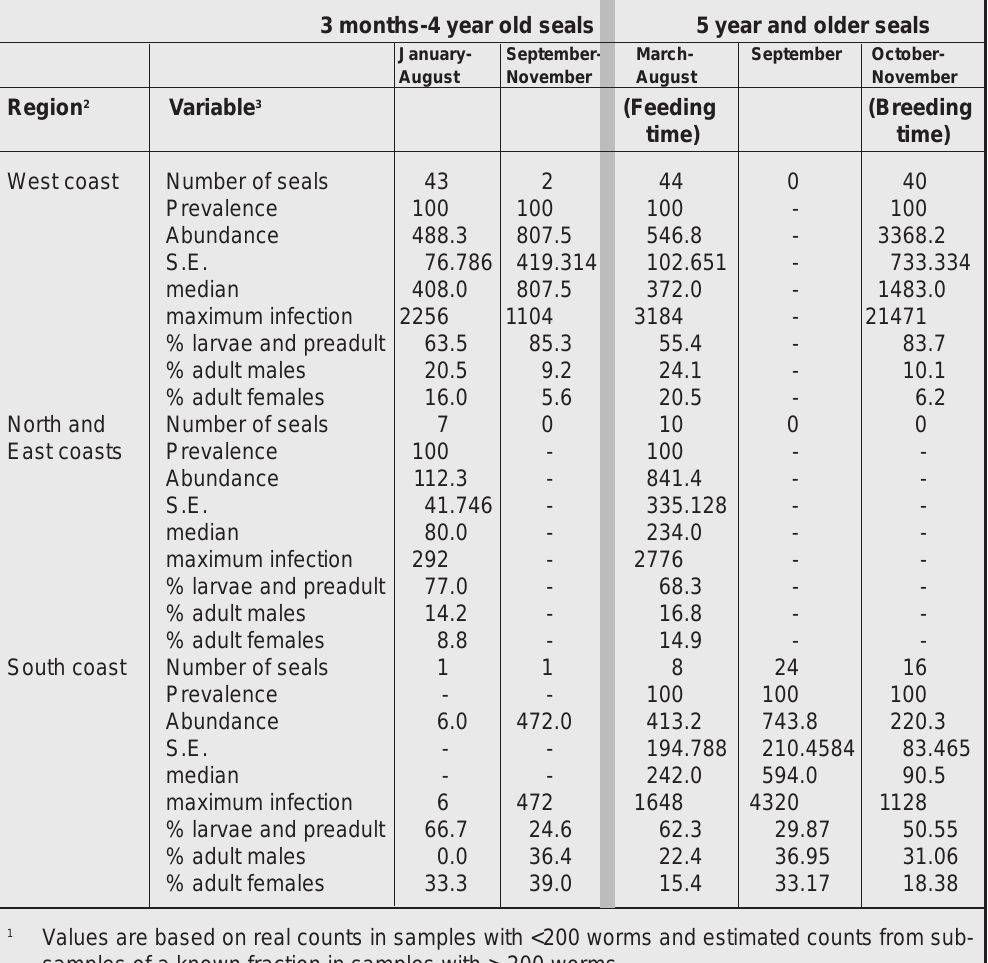
Table 4. Historical information on prevalence and abundance of sealworm ( Pseudoterranova de- cipiens ) in various fish species from Icelandic waters.